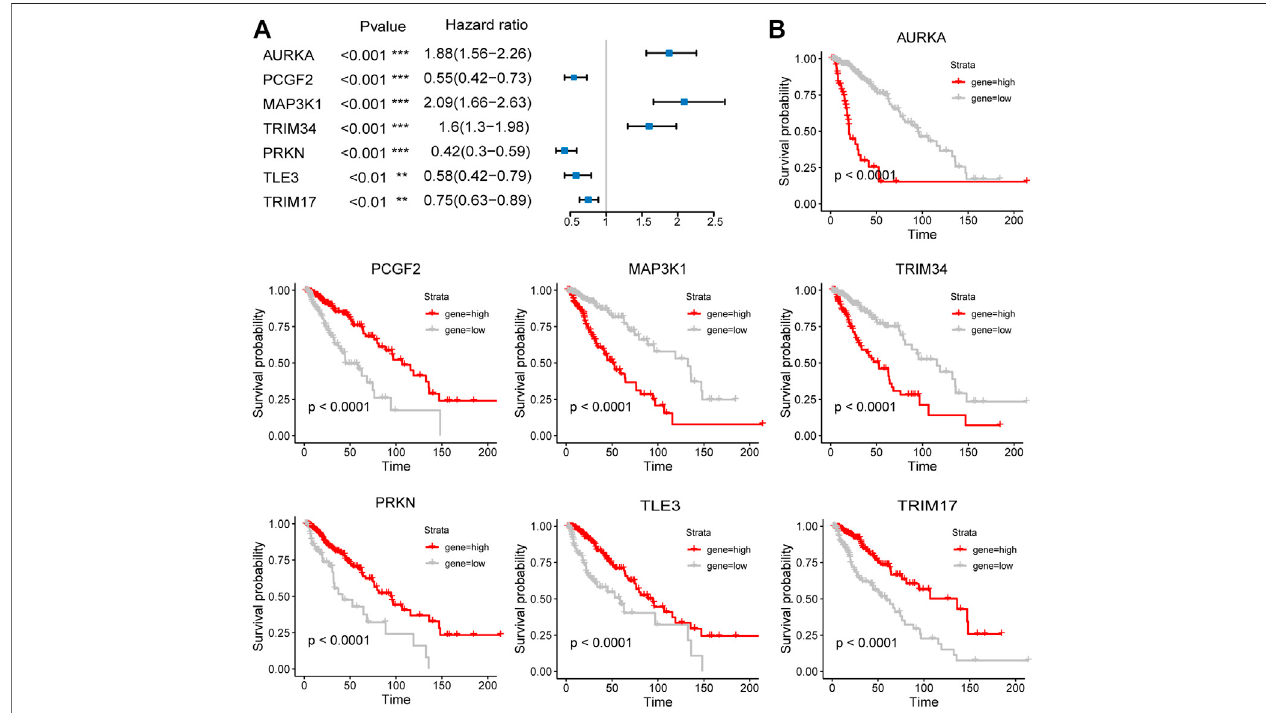
FIGURE 4 | Prognostic analysis of the seven-E3RG risk signature. Univariate Cox regression analysis (A) and Kaplan – Meier curves (B) of the seven-E3RG prognostic signature (** p < 0.01; *** p < 0.001).